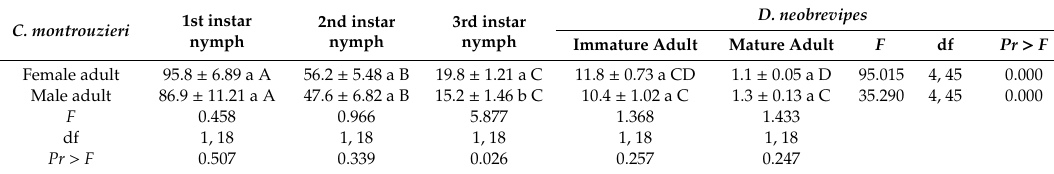
Table 2. Prey consumption rates (mean ± standard error) per day for adult Cryptolaemus montrouzieri on di ff erent life stages of Dysmicoccus